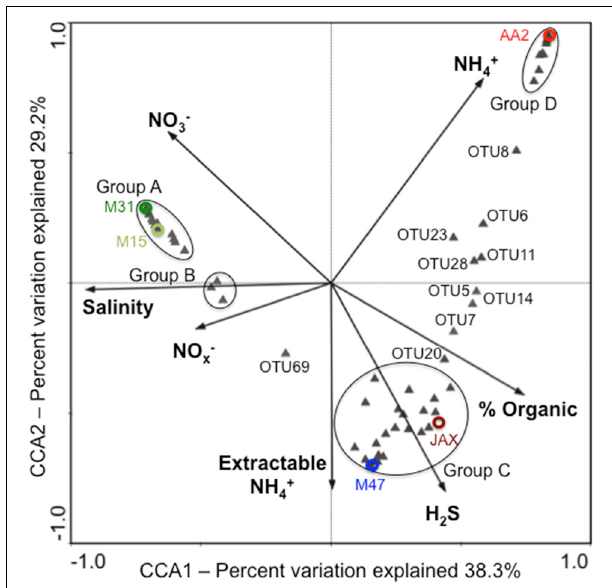
FIGURE 4 | CCA ordination plot deciphering the relationship between dominant NrfA OTUs and environmental variables in the New River Estuary. Color circles represent the ordinates of each community based on dominant OTUs. Some of dominant OTUs were clustered in groups as indicated with black circles. Group A contains OTUs 27, 31, 34, 36, 37, 38, 40, 41, 42, 43, 44, 46, 47, 48, 49, 50, 51, 52, 53, 54, 55, 56, 57, 66, and 68. Group B has OTUs25, 31, and 56. Group C carries OTUs 3, 4, 9, 12, 17, 21, 24, 29, 30, 32, 33, 35, 39, 58, 59, 60, 61, 63, 64, 65, and 67. Group D includes OTUs 1, 2, 10, 13, 15, 16, 18, 19, 22, 26, 45, and